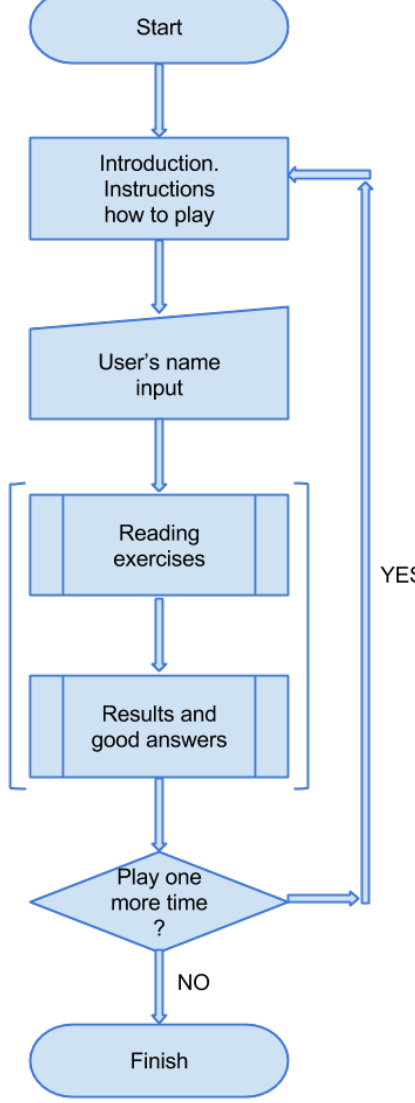
Figure 5. General flowchart of the